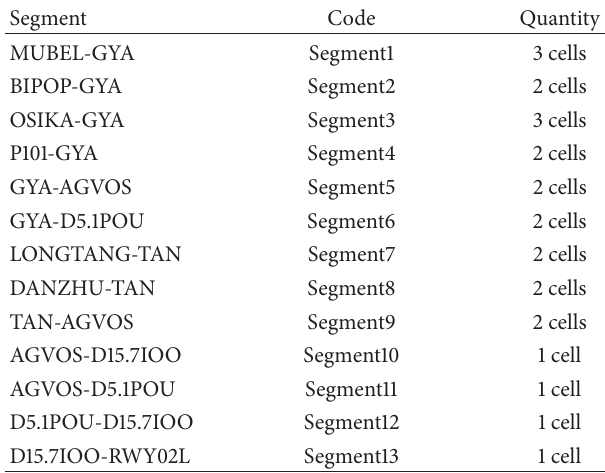
Table 1: Cell quantities of arrival routes to RWY02L ZGGG.